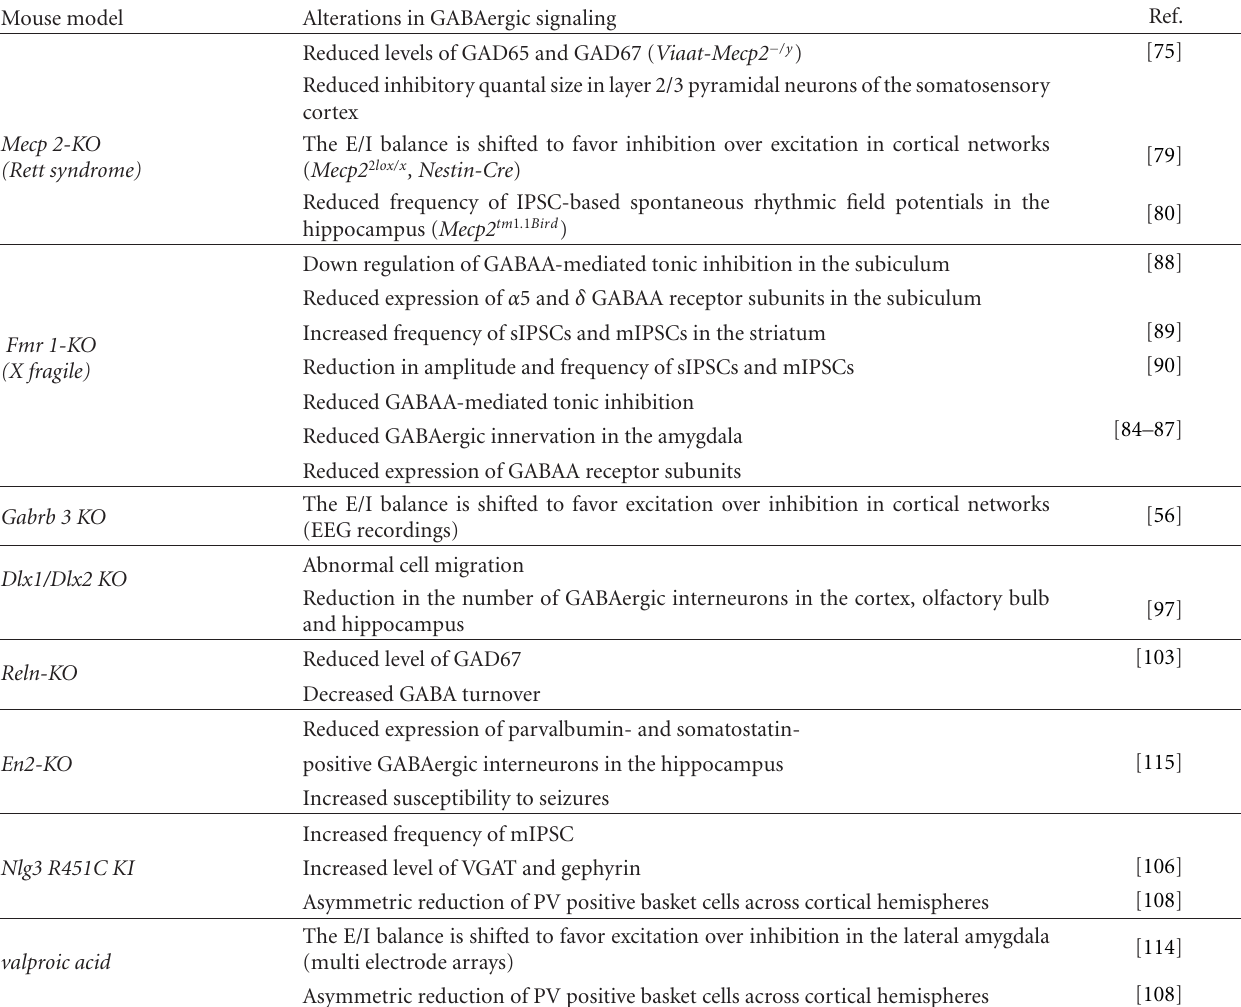
Table 1: Main alterations of GABAergic signaling present in di ff erent animal models of ASDs. For the Rett syndrome, di ff erent genotypes are expressed in